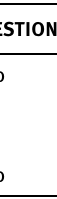
Table 1: The prototypical distribution of egophoricity